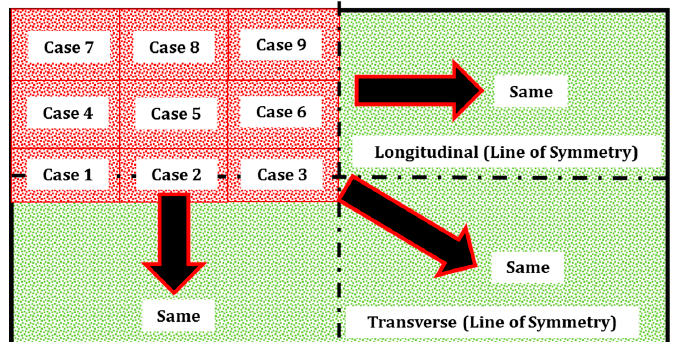
Table 4. Utilized cases for building the hazard map.